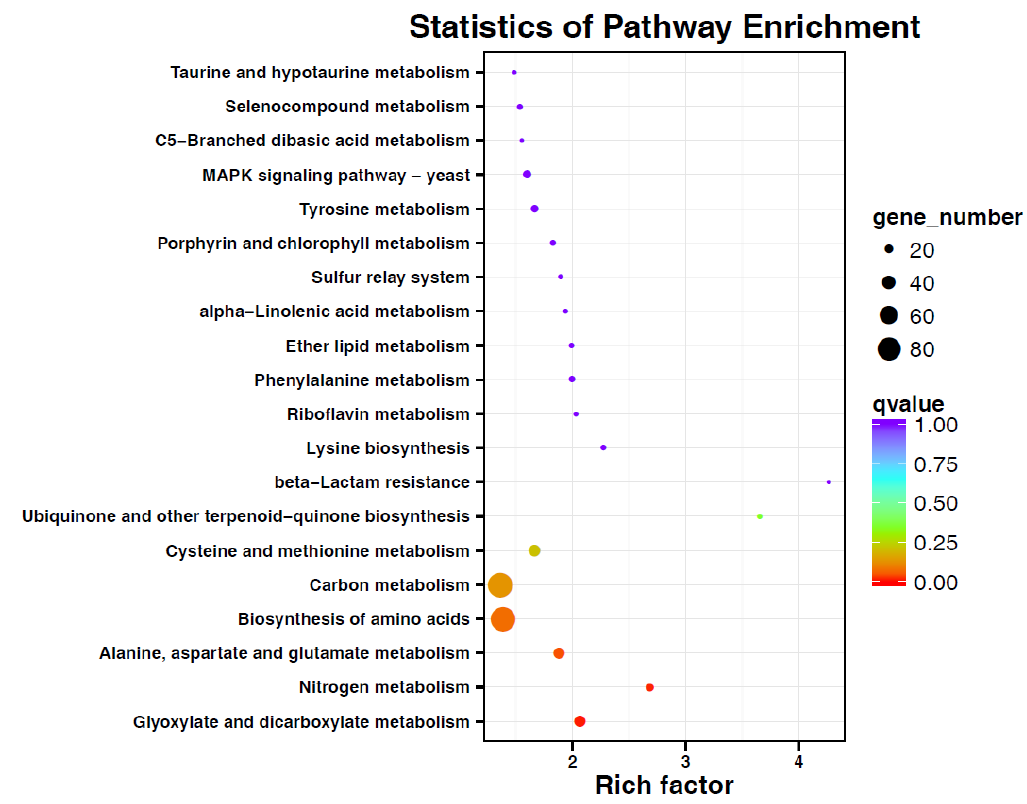
Figure 5. Kyoto Encyclopedia of Genes and Genomes (KEGG) enrichment analyses of differentially expressed genes in G. citri-aurantii underlying the treatment of cytosporone B.